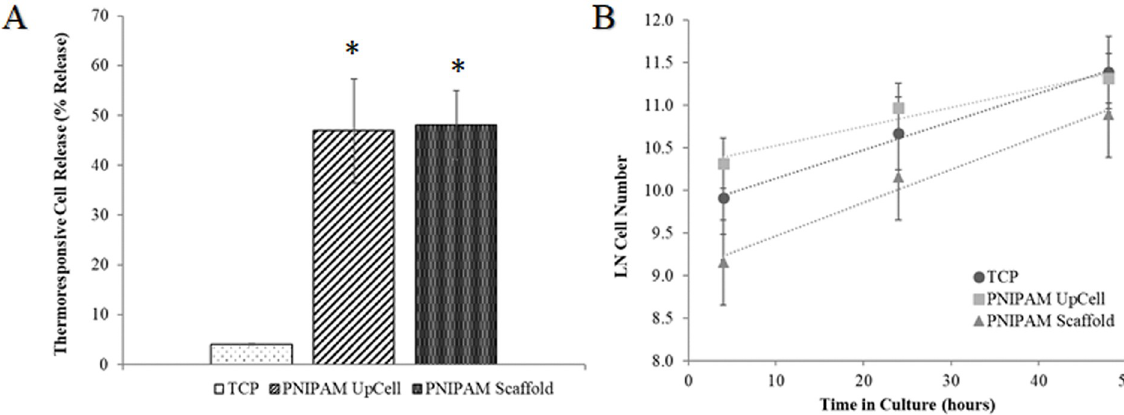
Fig 6. L929 cell attachment, thermorelease, and proliferation on cured PNIPAM nanofiber scaffolds compared to TCP and Nunc PNIPAM UpCell Surface. (A) Thermoresponsive release of L929 cells after 16 hours in culture. Cured PNIPAM nanofiber scaffolds were statistically similar compared to commercially available Nunc PNIPAM UpCell Surface. Tissue culture plastic (TCP) was used as a negative control. ( � p < 0.05 compared to TCP). (B) L929 cell attachment and proliferation on cured PNIPAM nanofiber scaffolds compared to TCP and Nunc PNIPAM UpCell Surface. Cell growth rates (a comparison of slopes) were statistically similar on all substrates. (p = 0.169 by General Linear Model Regression).